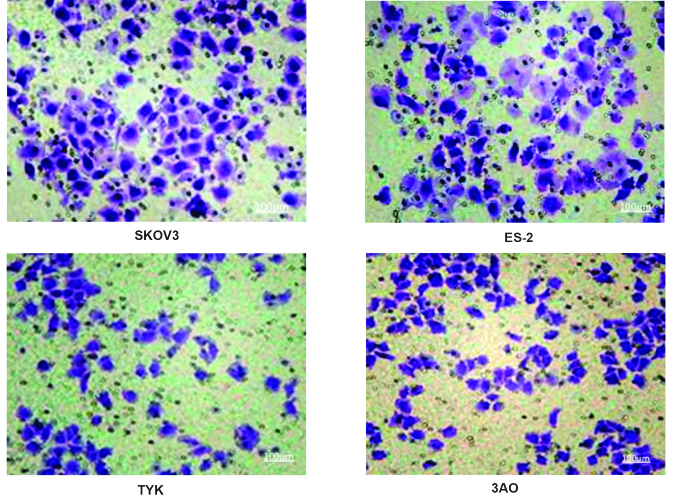
Results of invasion assay indicating that SKOV3 cells (132.6±6.4) and ES-2 cells (130.4±5.6) had a much higher metastatic potential than TYK cells (102.3±4.7) and 3AO cells (104.1±5.2).